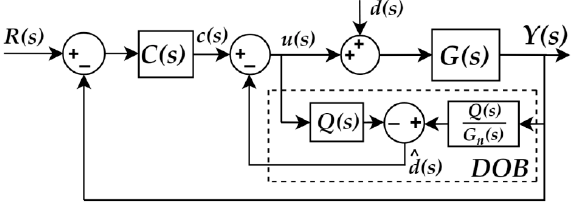
Figure 5. A DOB control structure.